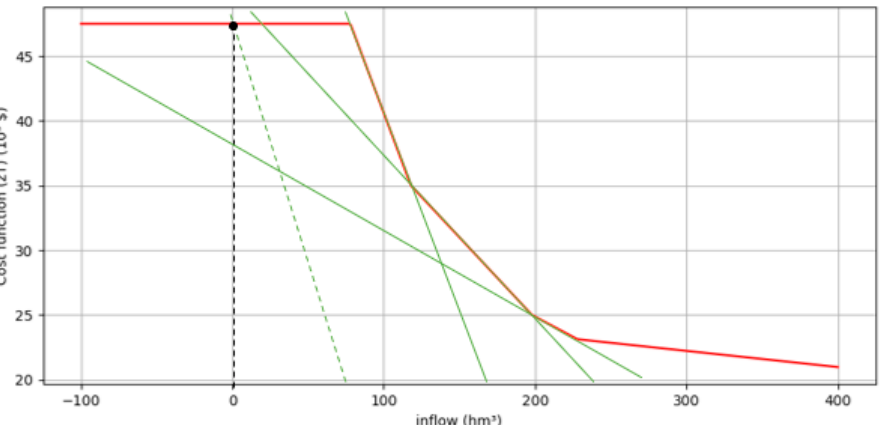
Figure 9. Primal LP problem of zT ( i , x − 1 ) (red line) and cuts formulated to convexify the problem (green